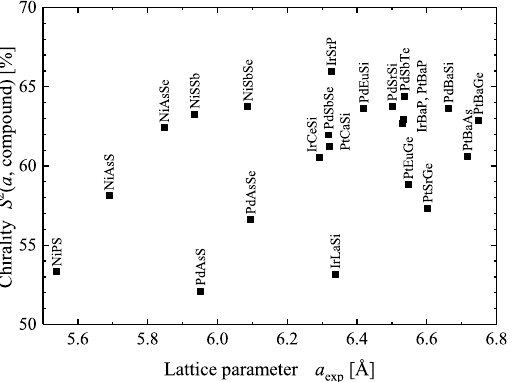
Figure 9. Chirality of the F 0 1 compounds. Continuous chirality measures of F 0 1 compounds where the complete structure determination is reported in the Pearson database